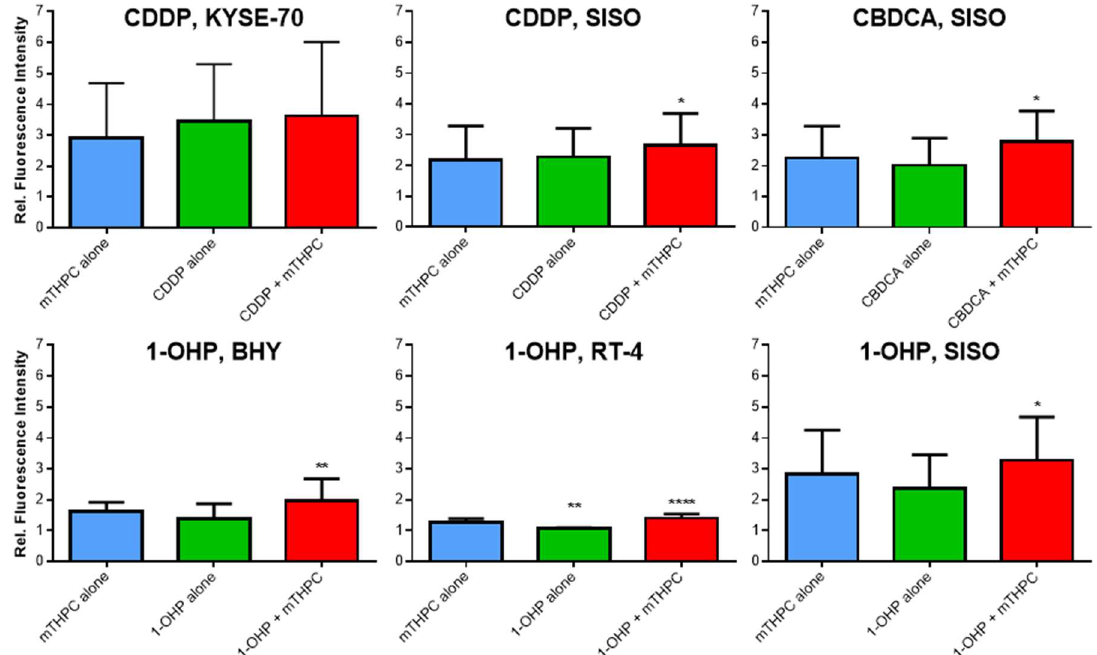
Figure 3. ROS formation after treatment with mTHPC or Pt(II) complex alone or in combination in various cell lines. Cells were illuminated with 1.8 J/cm 2 after treatment, stained with H 2 DCF-DA and DCF fluorescence intensity was measured by directly after illumination. Cells were gated for the single cell population and flow cytometric analysis was carried out using the B1 channel ( λ Ex/Em = 488 nm/525–550 nm). Fluorescence intensity was plotted relative to a solvent-treated, non-illuminated negative control (fluorescence intensity set to 1.0, not shown). Data presented as means ± SD from at least three independent experiments. (* p < 0.05; ** p < 0.01; *** p < 0.001; **** p < 0.0001). Statistical comparisons were always made between substance treated samples and a solvent-treated, non-illuminated reference control.